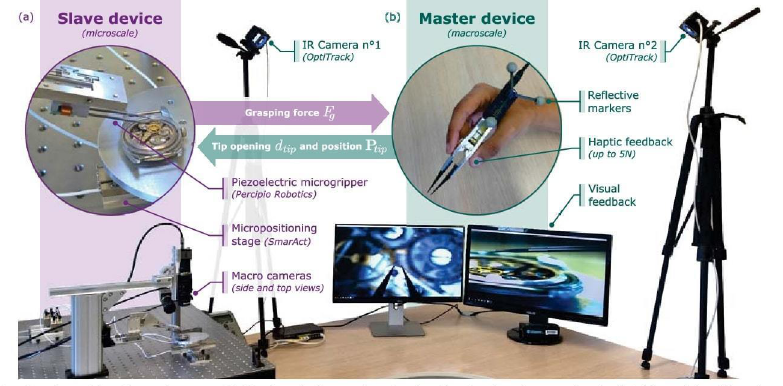
Fig. 4. The TéléTweez cobotic